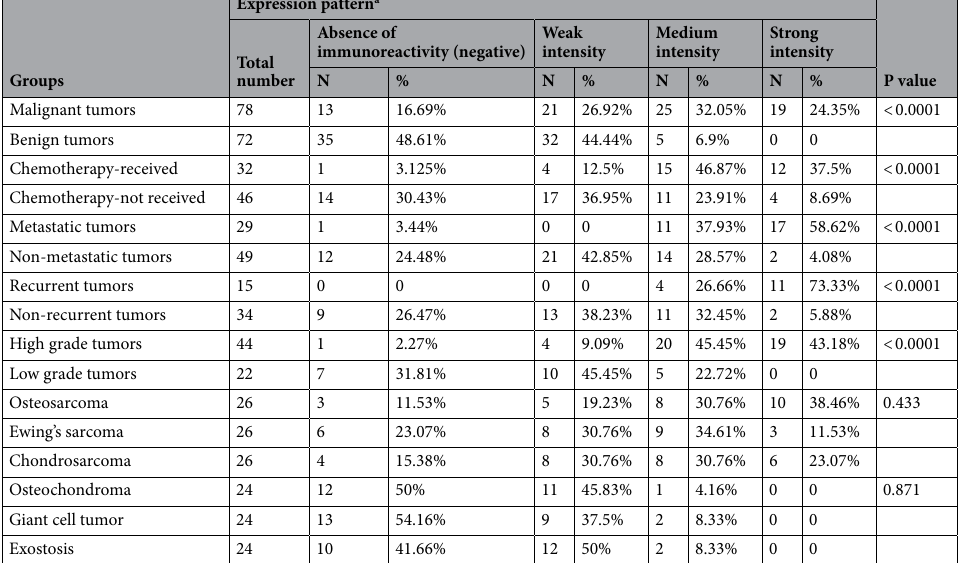
Table 3. The immunohistochemistry results of β-catenin protein evaluation in patients with different types of bone cancer. a The expression pattern was determined based on the staining intensity of β-catenin antibody that is described in “Material and